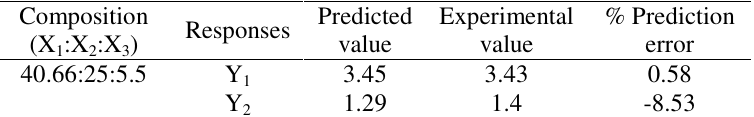
Table 5 . Optimum chromatographic conditions and comparison of the experimental and predicted values of the responses